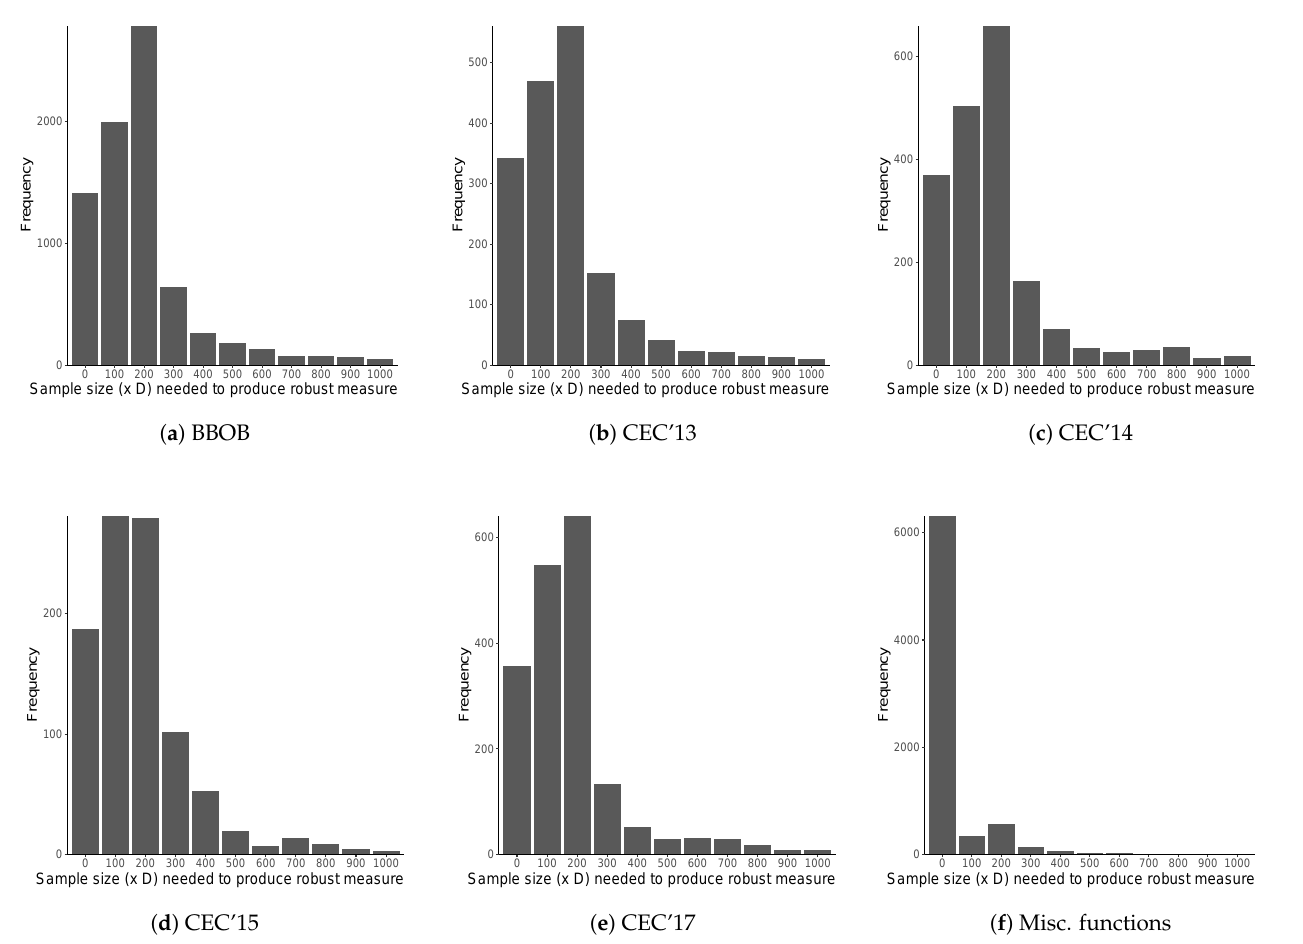
Figure 2. Plots of the distribution of the point of robustness for each of the investigated benchmark suites in D = 10 dimensions.